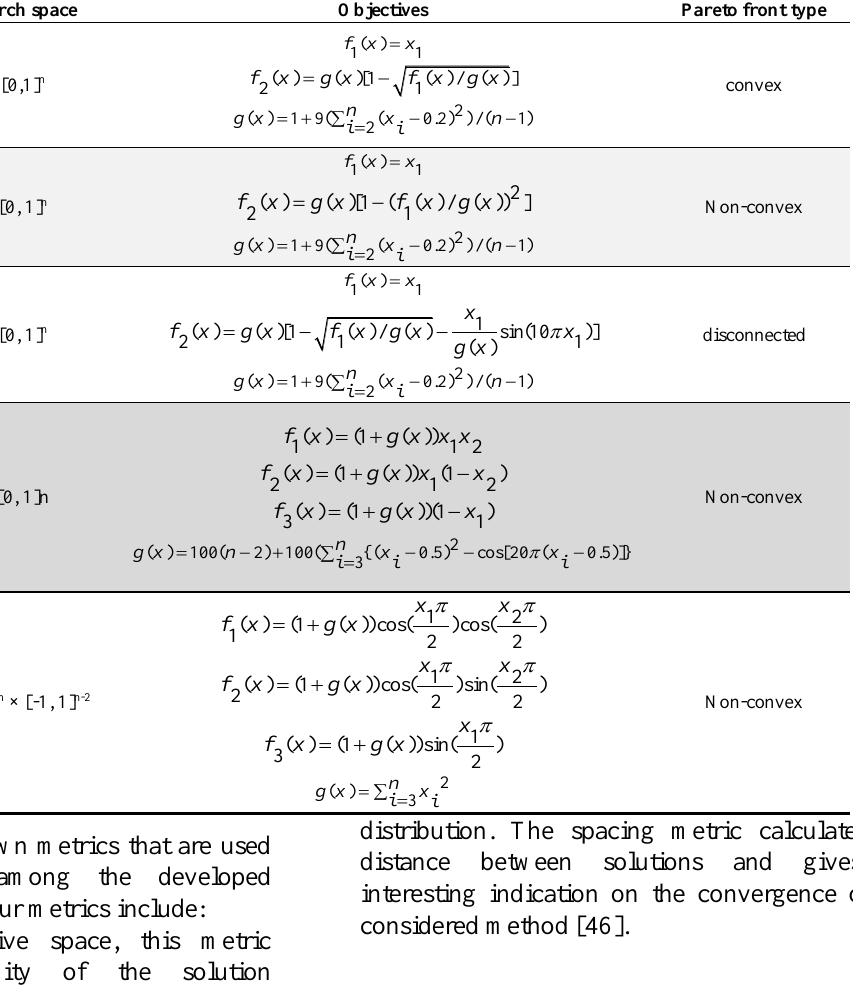
Table 2. Experimental